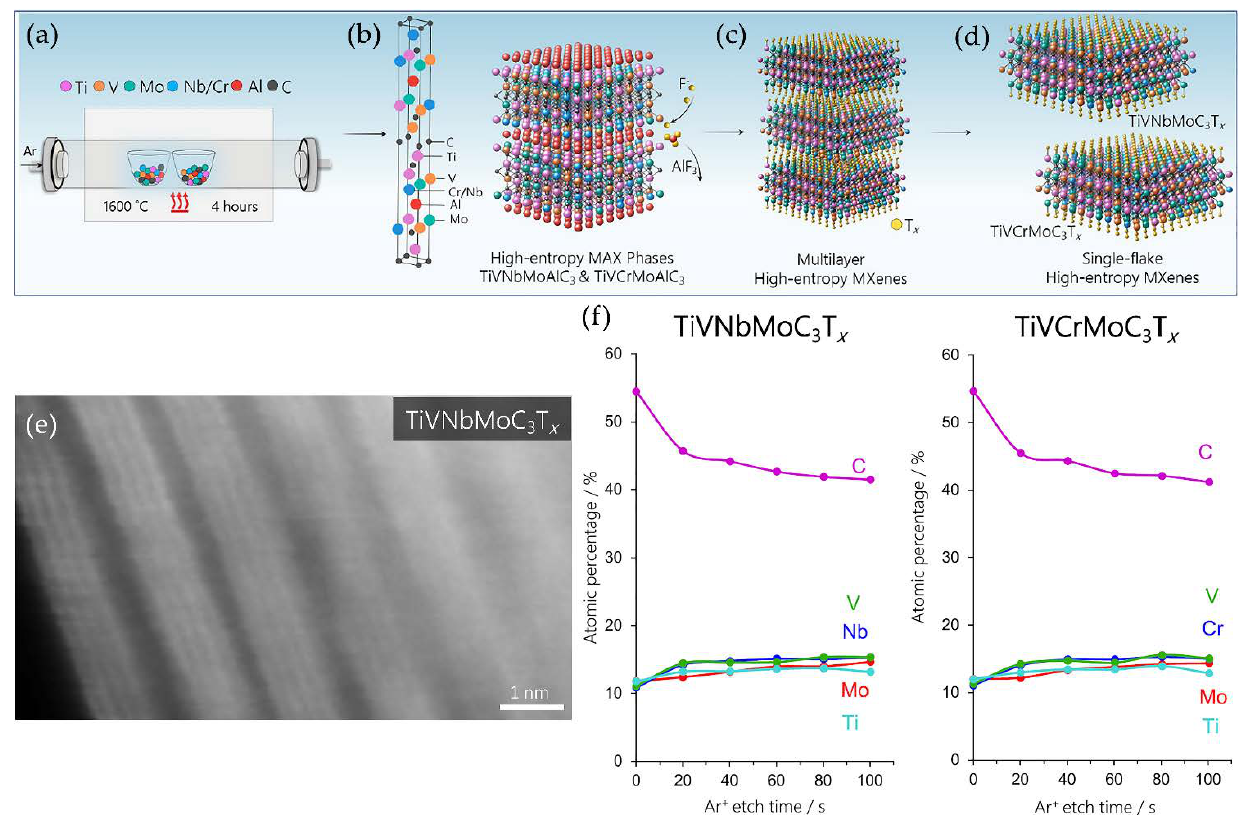
Figure 22. Schematic illustrations of the ( a ) synthesis of high-entropy alloy MAX phases through sintering of powers with stoichiometric molar ratios, ( b ) unit cell of the TiVNbMoAlC 3 and TiVCrMoAlC 3 (M 1 M 2 M 3 M 4 AlC 3 ) MAX phases, where elements are designated as follows: Ti—pink, Nb/Cr—blue, Al—red, V—orange, Mo—green, and C—black. Selective etching of the Al layers by hydrofluoric acid to synthesize multilayer high-entropy MXenes. The process of the selective etching of the MAX phase for MXene synthesis. ( c ) Multilayered and ( d ) single flakes of high-entropy MXenes TiVNbMoC 3 T x and TiVCrMoC 3 T x after delamination, where functional surface groups (-O/-F) are colored in yellow. ( e ) SEM image of the high-entropy TiVNbMoC 3 T x MXene, showing four layers of metals, which is characteristic of the M 4 C 3 T x structure. ( f ) XPS in-depth distribution of metal elements and carbon in synthesized MXenes. Reprinted with permission from [104] 2021 American Chemical Society.